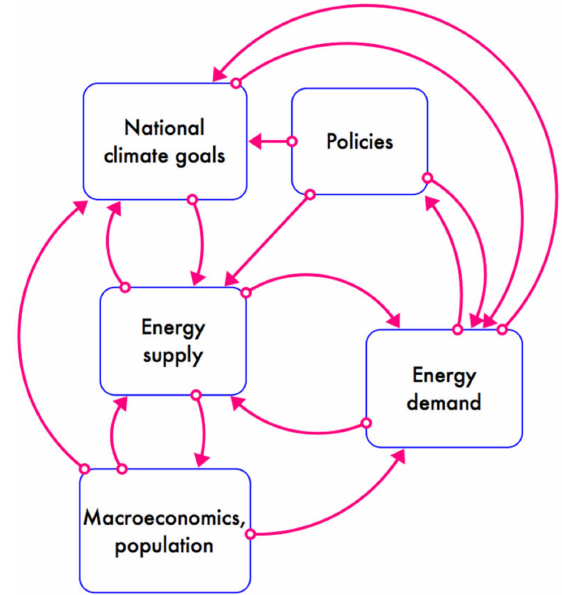
Figure 2. Aggregated level structure of the